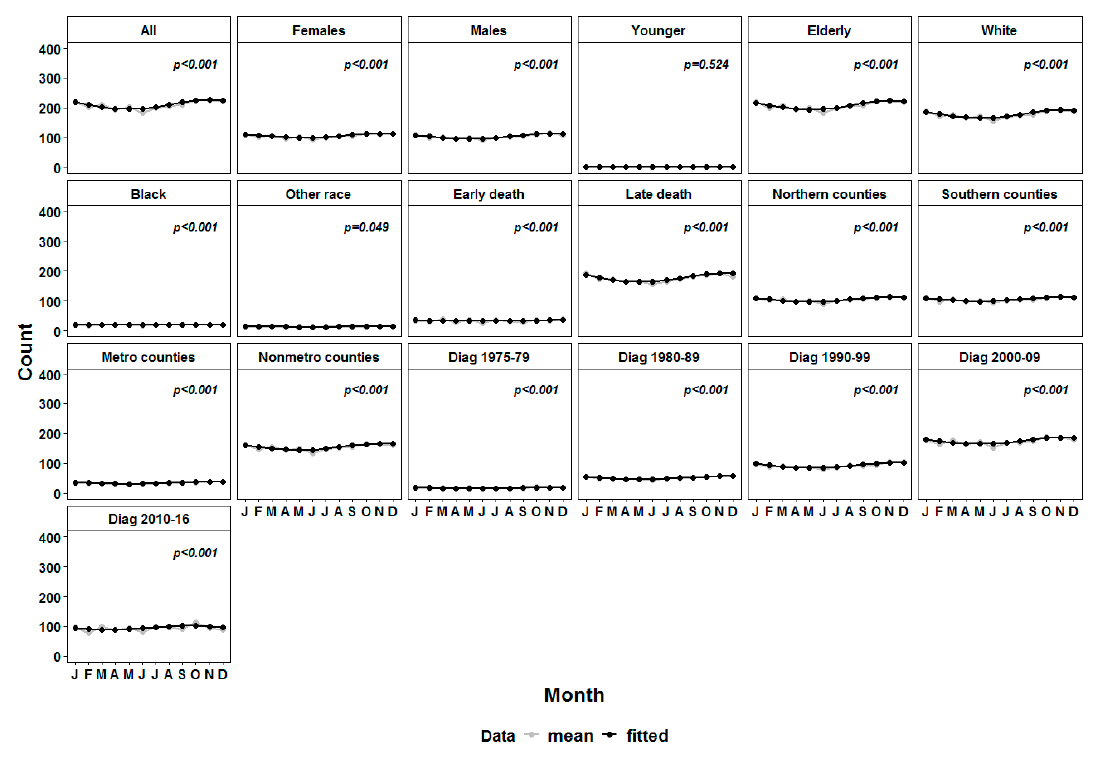
Figure 1. Curves of the number of deaths due to the fact of cerebrovascular diseases in all patients and main subgroups (in grey) versus the fitted cosinor model values (in black).